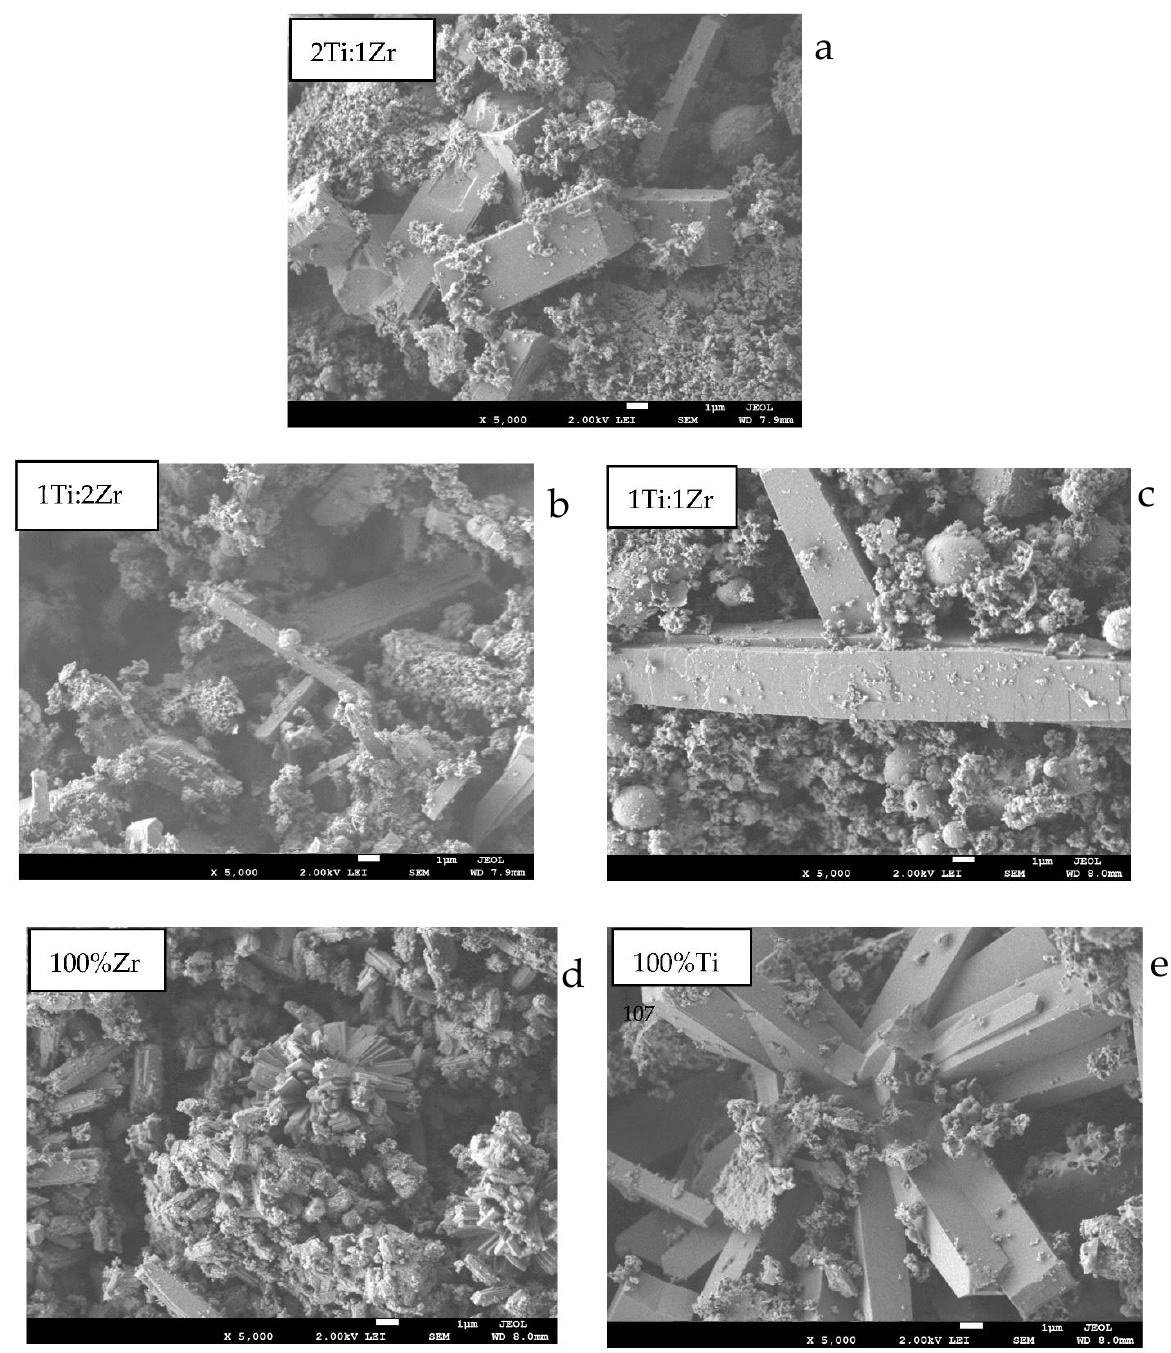
Figure 2. SEM Image of investigated samples : ( a ) 2Ti:1Zr; ( b ) 1Ti:2Zr; ( c ) 1Ti:1Zr; ( d ) 100% Zr; ( e ) 100% Ti.